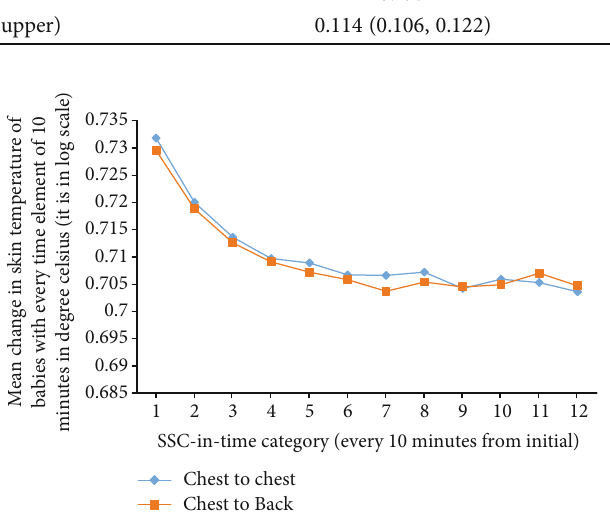
Figure 4: The distributional curve for the e ff ect of CB-SSC and CC-SSC by time. Table 5: The pairwise comparison output of our fi nal linear mixed-e ff ect